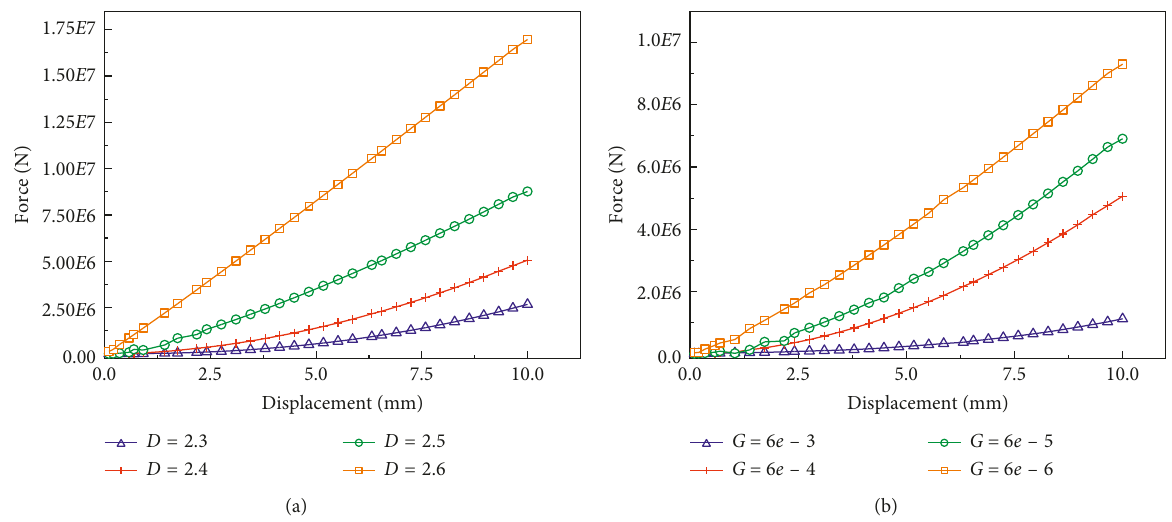
Figure 7: Normal contact reaction force versus displacement for contact interfaces with different fractal parameters: (a) fractal dimension D ; (b) fractal roughness G .